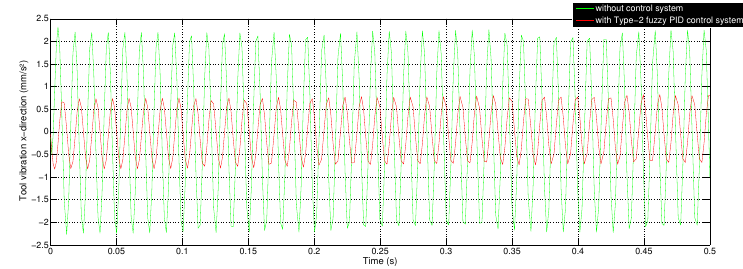
Figure 12. Tool vibration along x − direction using type-2 Fuzzy PID control.